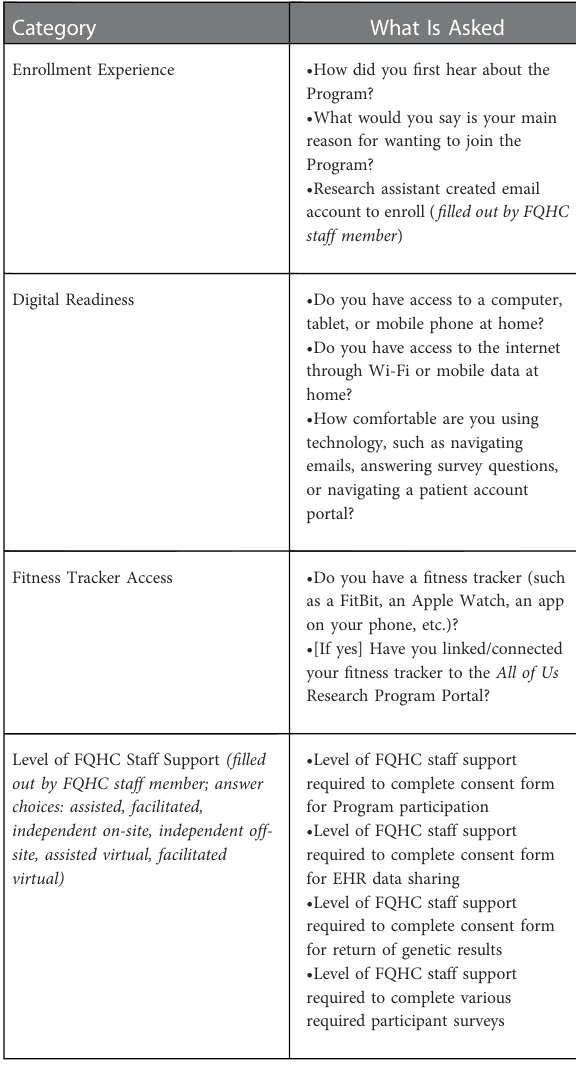
TABLE 3 FQHC MCM